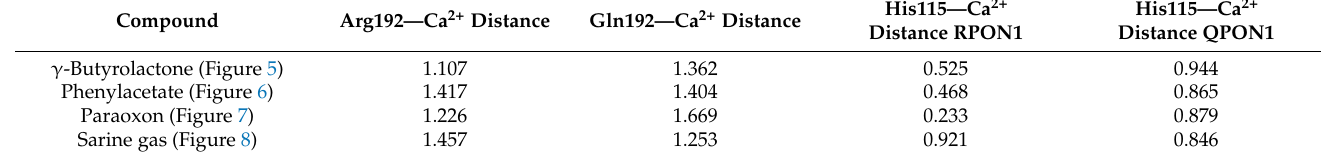
Figure 6. The distance between residue192 and Ca 2+ ion in the active site of the Phenylacetate com- plex after 20 ns. ( A ) is the QPON1. ( B ) is the RPON1 .